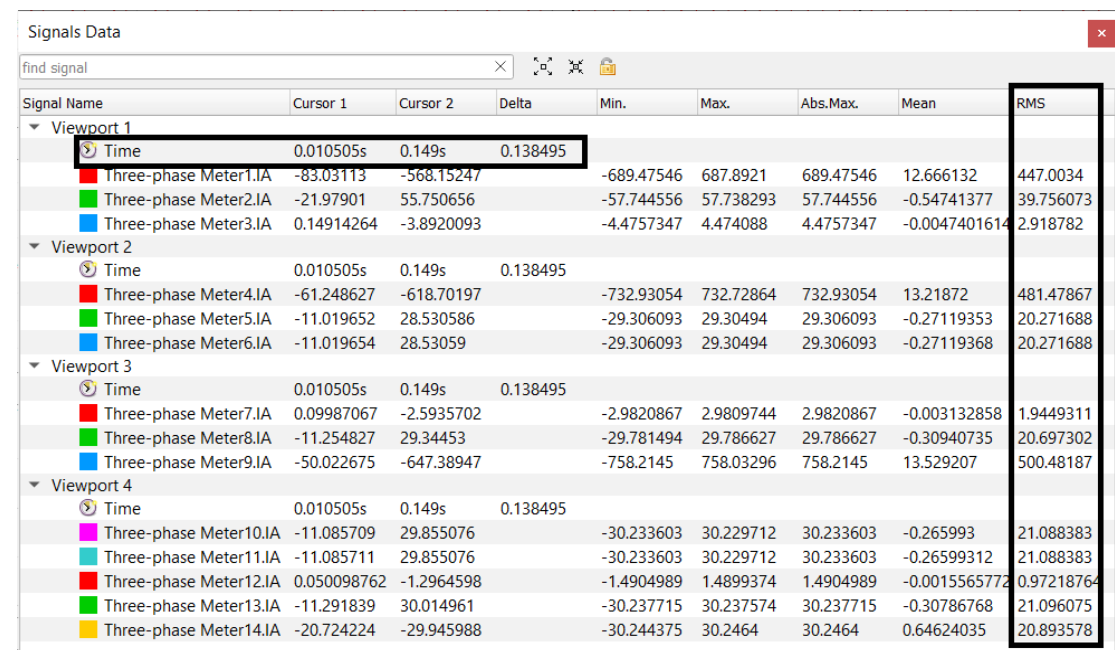
Figure 9. A 3LG fault at bus 9 in grid-connected mode.